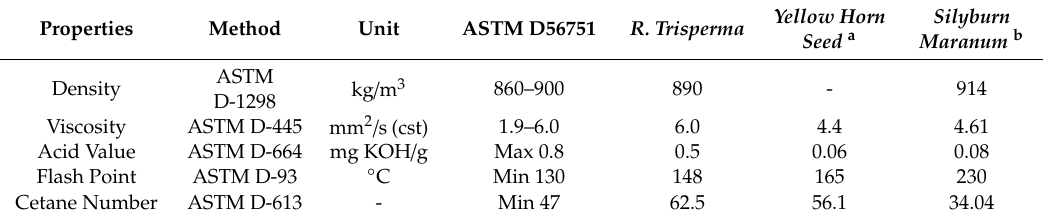
Table 2. Properties of biodiesel based on ASTM D56751.